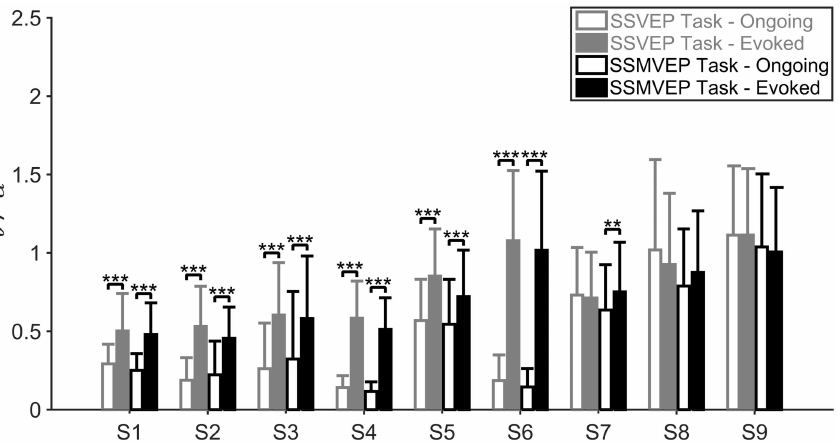
Fig 1. Comparison of mental load between the evoked EEG and ongoing EEG in both of flickering SSVEP-BCI and motion-reversal SSMVEP-BCI tasks for individual subjects. The mean values and SD of the ratio index θ / α of individualsubjects within SSVEP-BCI and SSMVEP-BCI tasks were calculated. All statistics were assessed by unbalancedone-way ANOVA, *** p < 0.001 between evoked EEG and ongoing EEG, ** p < 0.01 between evoked EEG and